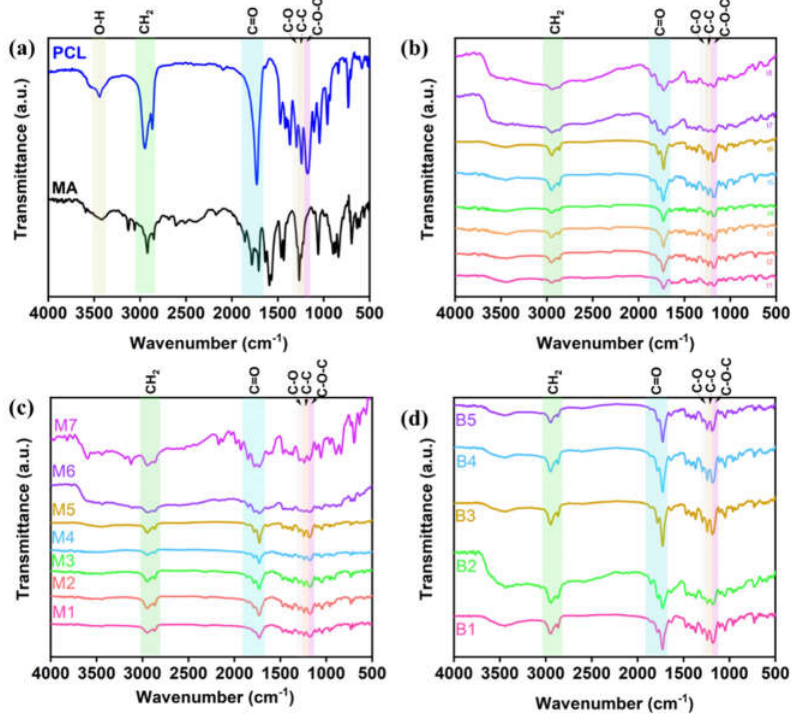
Figure 1. FTIR spectra of ( a ) PCL and MA, and PCL-g-MA synthesized with different ( b ) reaction periods, ( c ) amounts of MA and ( d ) amounts of DBPO.